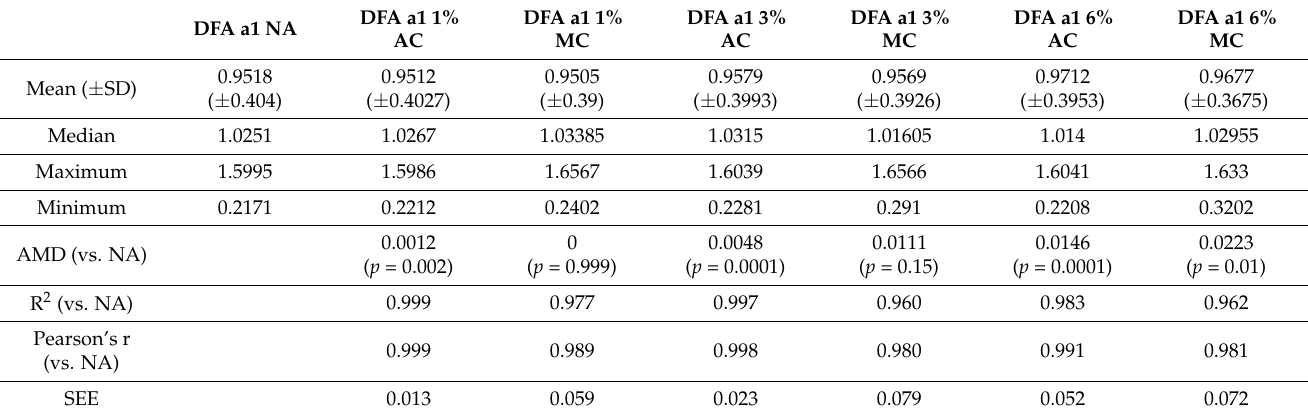
Table 1. Two-minute measurement windows derived from ECG recordings for DFA a1 no artefact (NA) vs. artefact containing (1, 3, 6%) data and correction method (automatic, AC, medium threshold, MC): Mean ( ± standard deviation, SD), Median, Minimum, Maximum, adjusted median difference (AMD) from DFA a1 vs. NA according to Hodges Lehmann method ( p -value estimated by Wilcoxon paired testing), coefficient of determination (R 2 ), Pearson’s r and Standard Estimate of Error (SEE) from paired data of DFA a1 NA vs. DFA a1 for each artefact condition and correction method. DFA a1